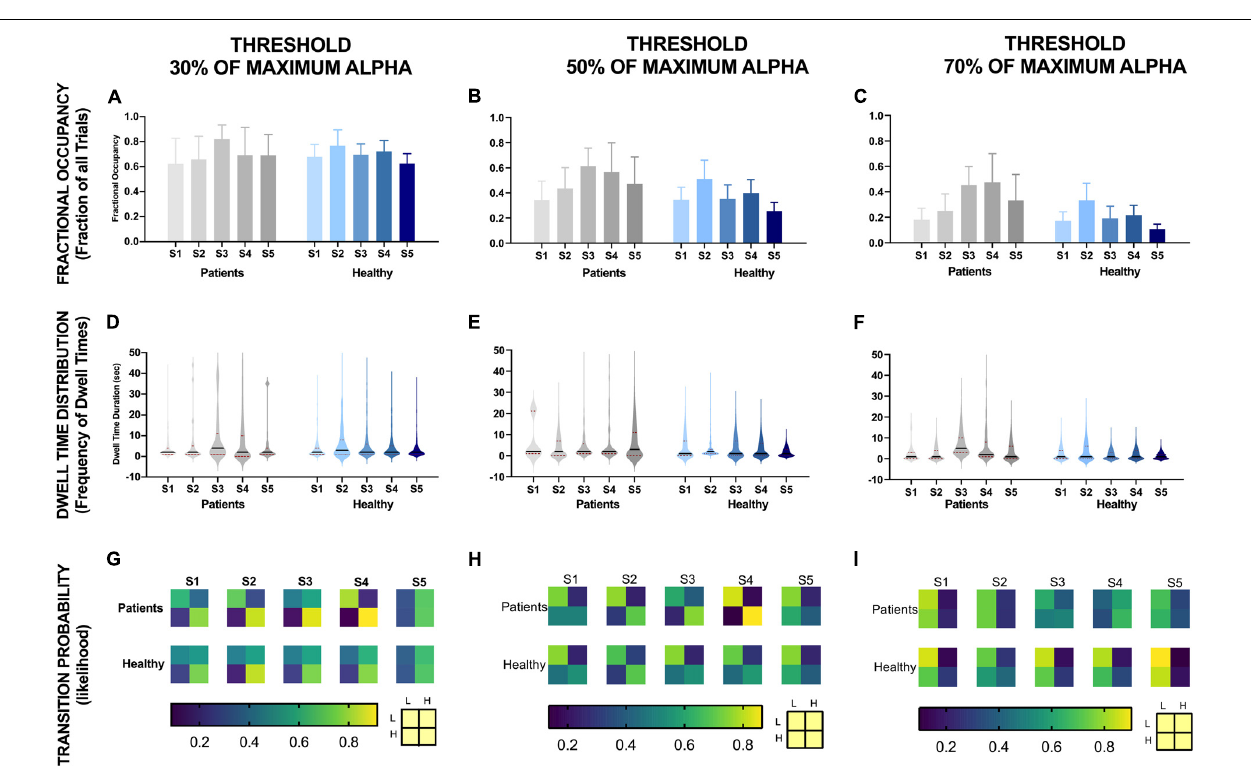
FIGURE 6 | EEG alpha state parameters over five NFB sessions in chronic pain patients and healthy participants for different thresholds. NFB sessions are denoted by